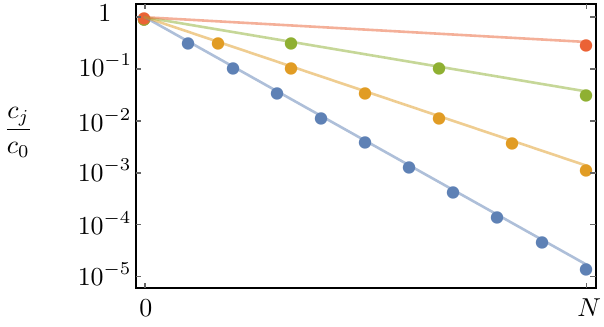
1) gv to ( q +1) gv (cid:0)